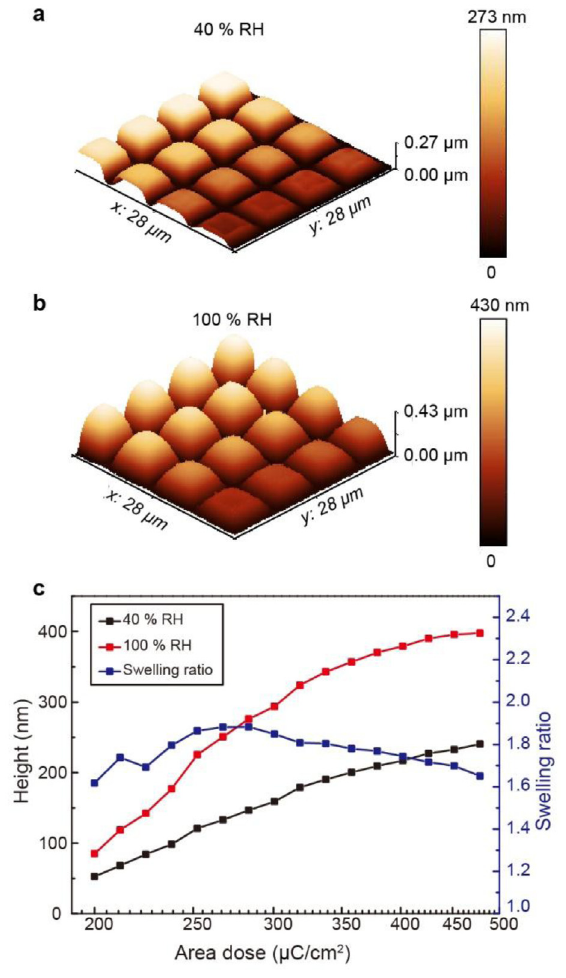
Fig. 2. e-AFM images of hydrogel structures with controlled ambient humidity at (a) 40% RH and (b) 100% RH. (c) Height and calculated swelling ratio of PVA structures exposed with varied dose measured at 40% RH and 100%